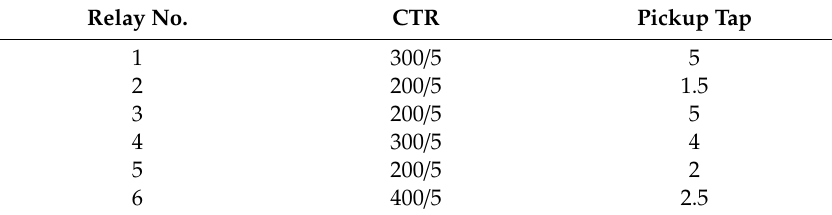
Figure 3. The IEEE three-bus system. Table 1. Proposed setting for the IEEE three-bus system.